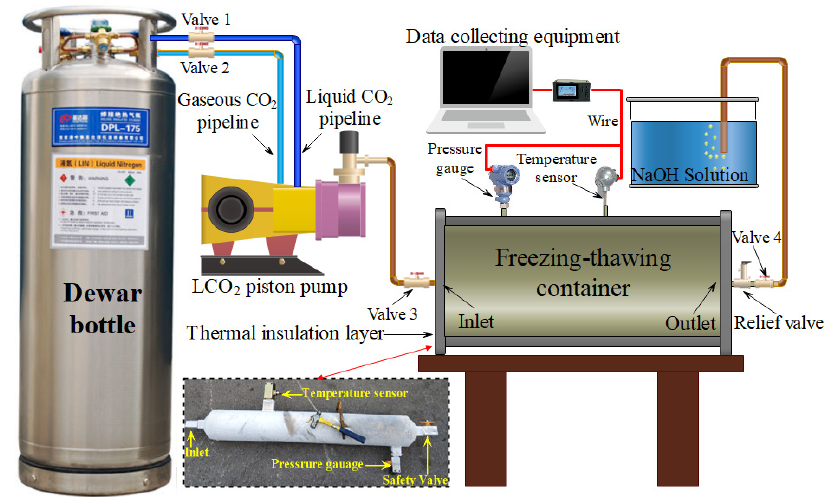
Figure 3. Diagram of the cryogenic L-CO 2 cyclic freeze–thaw experimental system.